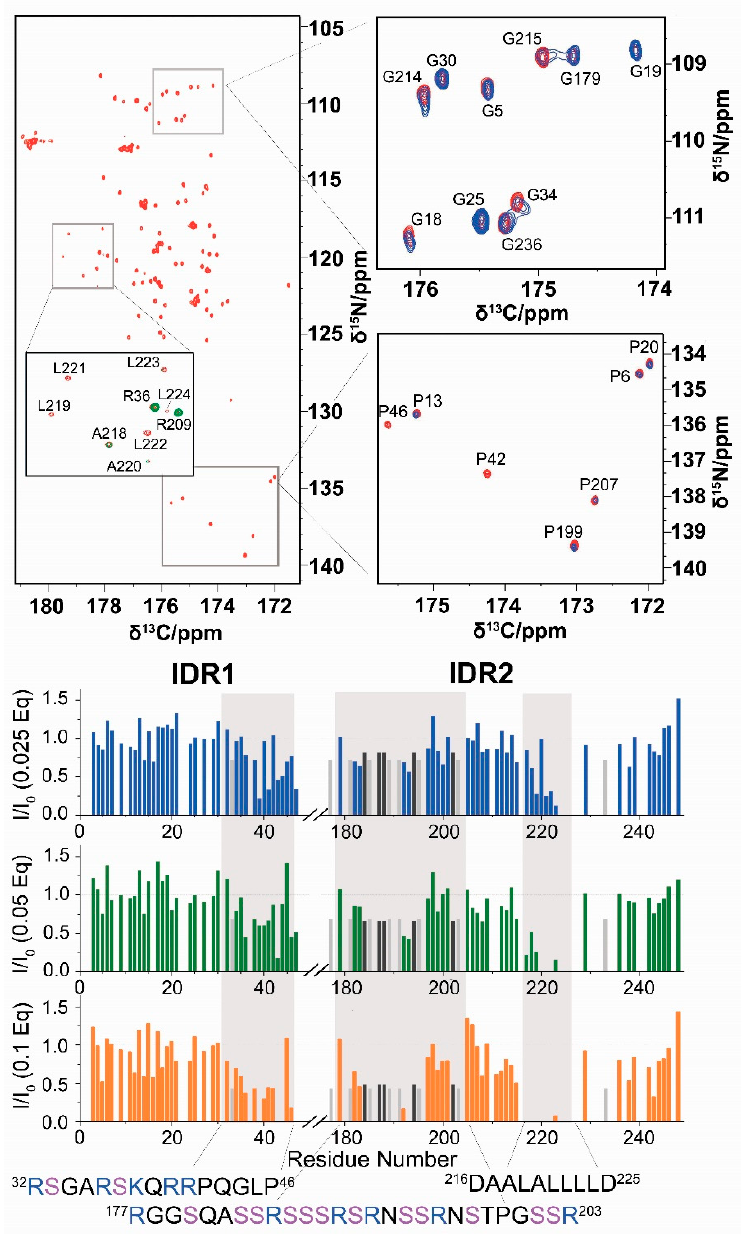
Figure 3. 2D CON experiments reveal differential effects of RNA-binding in specific regions of IDR1 and IDR2. The CON spectrum acquired on NTR is reported in red ( top , left ). The inset shows the superposition of the reference spectrum with NTR upon the addition of 0.01 eq of RNA (green). The enlargements of two portions of the spectra reported on the right panels (namely, the typical Gly and Pro regions) show the spectrum acquired on the NTR upon the addition of RNA (0.1 equivalents, blue) superimposed to the spectrum acquired in the absence of RNA (reference, red). The intensity ratios of CON cross-peaks are reported in the lower panel versus the residue number; spectra were acquired simultaneously to the HN spectra. Light and dark gray bars represent the intensity ratio of the envelope of signals centered at 176.6 ppm ( 13 C)–116.5 ppm ( 15 N) and 174.8 ppm ( 13 C)–117.9 ppm ( 15 N), respectively. Gray shaded areas highlight the protein regions most perturbed upon the addition of